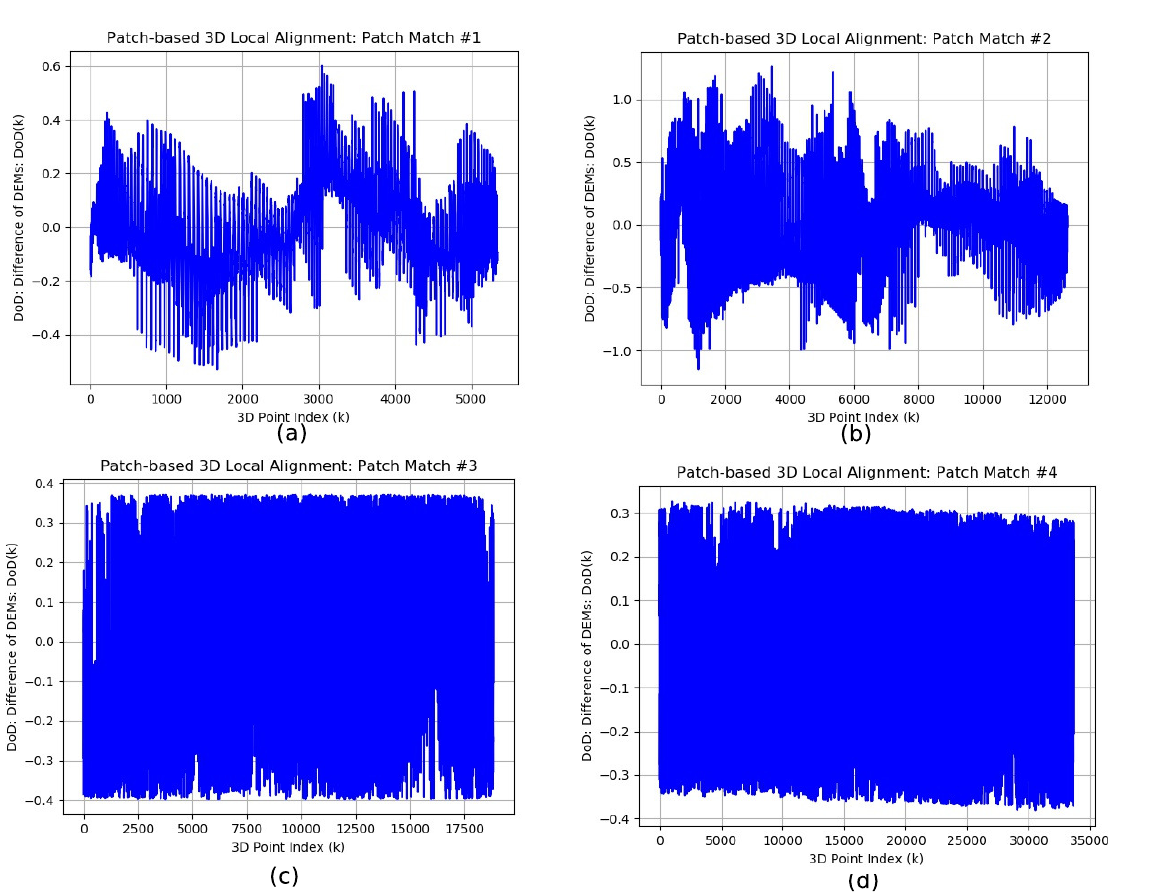
Figure 7. Experimental results obtained on the dataset Fabas: output generated by the local fine alignment procedure performed for each patch match, with N = 4 homologous patches: (a) - (d): DoD (Difference of DEMs) altimetric residual values corresponding to each inlier index, k = 1 , .., n in , for each